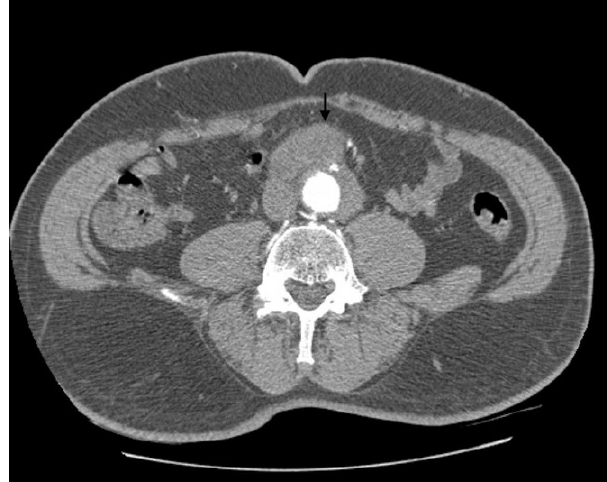
Figure 1 - Computed tomography in the axial plane shows the chronic pseudoaneurysm of the infrarenal aorta.